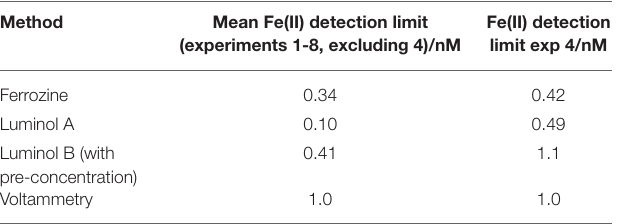
TABLE 3 | Mean Fe(II) detection limits (defined as 3 standard deviations of an aged seawater blank for luminol A/voltammetry/ferrozine; and as 3 standard deviations of an analytical cycle without sample flow for luminol B) determined during the method comparison